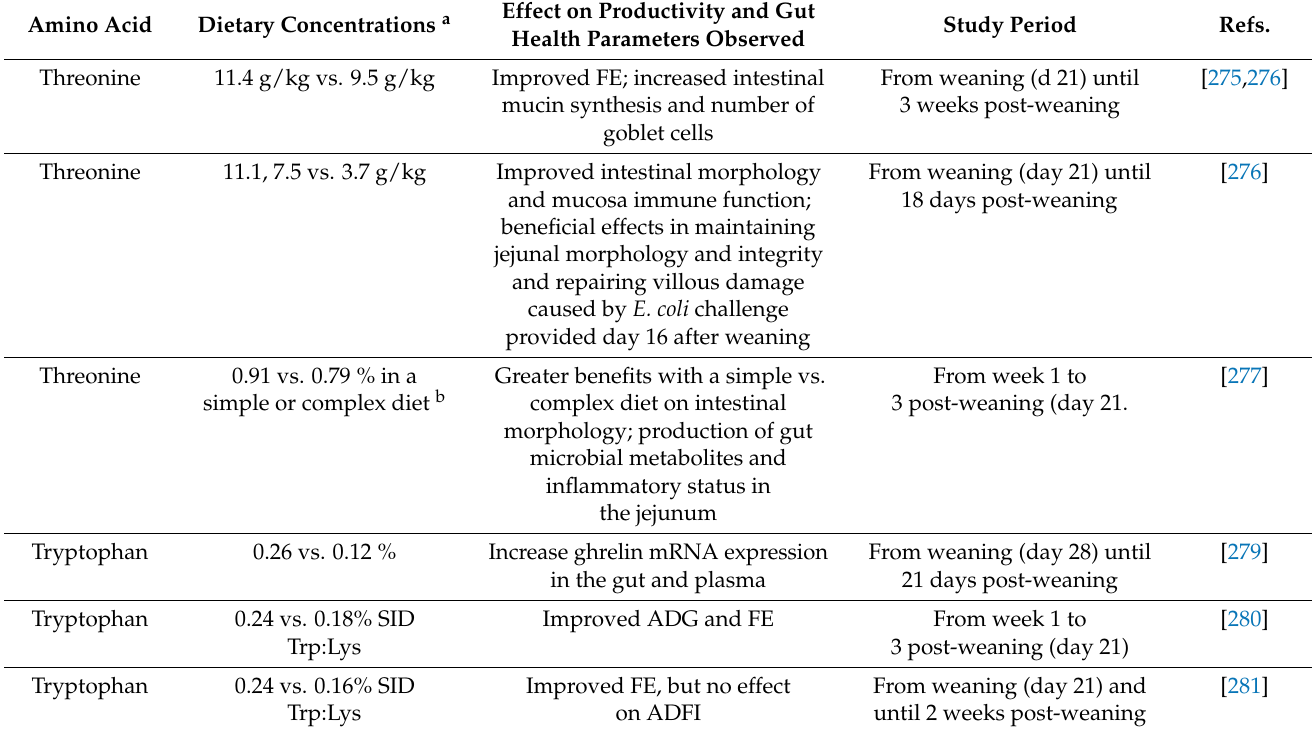
Table 9. Effects amino acids of algae on various parameters in